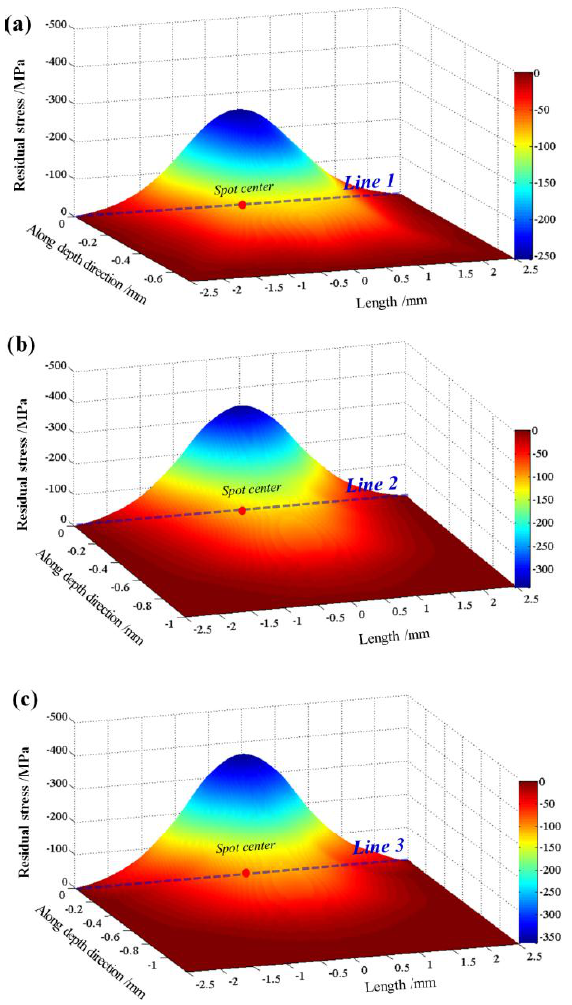
Figure 4. In-depth residual stress three-dimensionally displayed distributions along the diameter of laser spots with different LSP impacts. ( a ) Single LSP impact; ( b ) dual LSP impacts; and ( c ) triple LSP impacts.